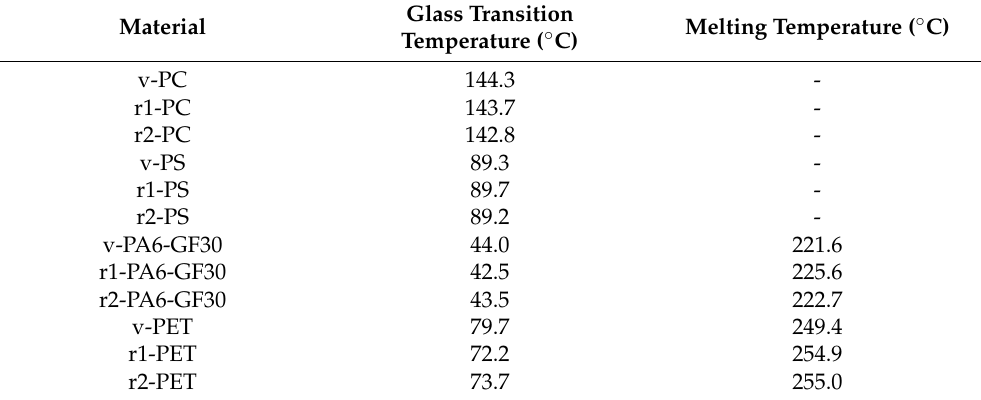
Table 2. Glass transition and melting temperature for virgin and recycled